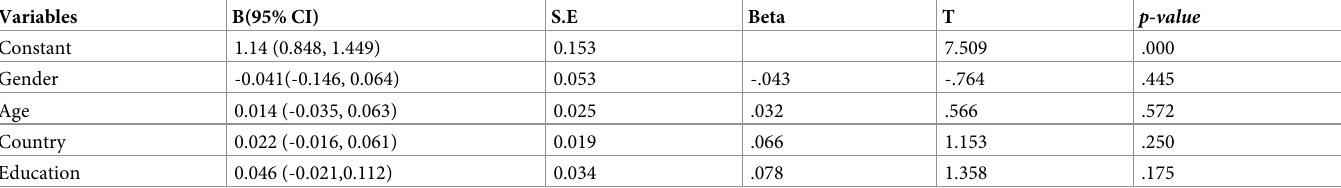
Table 8. Multivariable linear regression about perception about B.1.1.529.